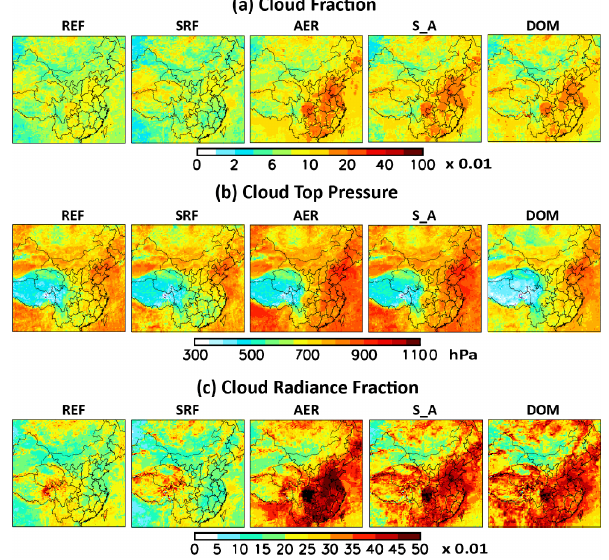
Figure 7. Annual mean (a) cloud fraction, (b) cloud top pressure and (c) cloud radiance fraction retrieved via different approaches. Provincial boundaries of China are shown. Data are sampled from valid pixels of case REF. Values outside the upper (lower) bound of color intervals are shown in black (purple). Missing values are shown in grey. Color intervals in (a) are nonlinear to better present the data range; an interval without labeling represents the mean of the adjacent two